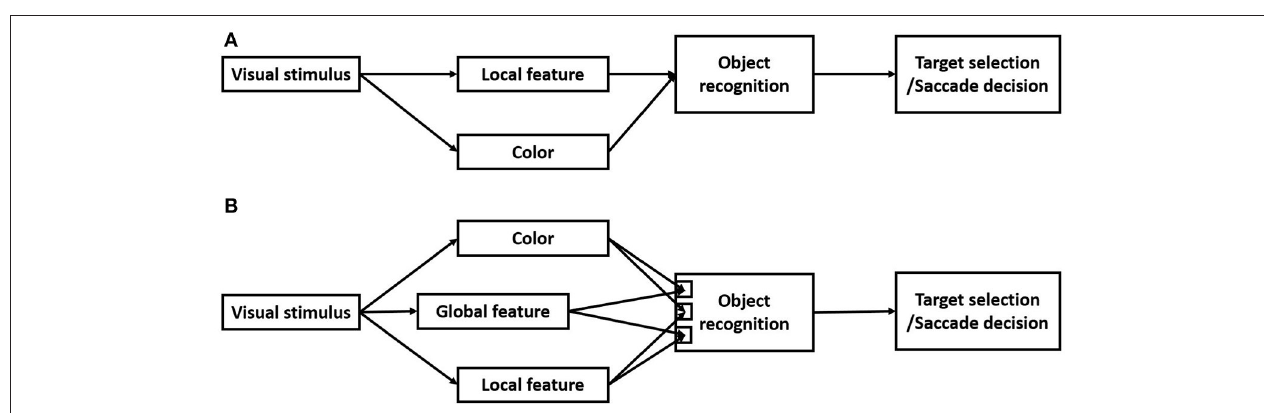
FIGURE 10 | (A) Current local-to-global models of vision. Local features and color information are extracted in parallel in the early visual pathways. The global features are extracted in later visual pathways for object recognition. (B) A new model of vision based on the results of the present study. The global features are processed as a basic visual modality, and in parallel or even prior to the local features and color. However, there are interactions of processing the local features and the global features.